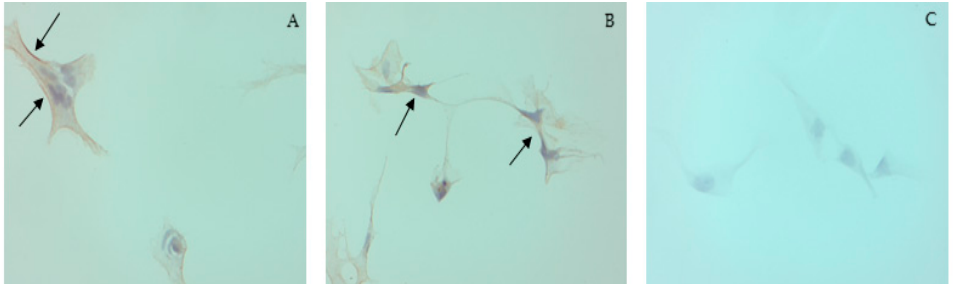
Figure 1. Results of immunohistochemistry performed on RTgill-W1 cells. The pictures are referring to the control ( A ), concentration 0.5 w / w F1-BEO ( B ) and the negative control ( C ). Black arrows indicate the positivity to TRPV1. Magnification: 40×.